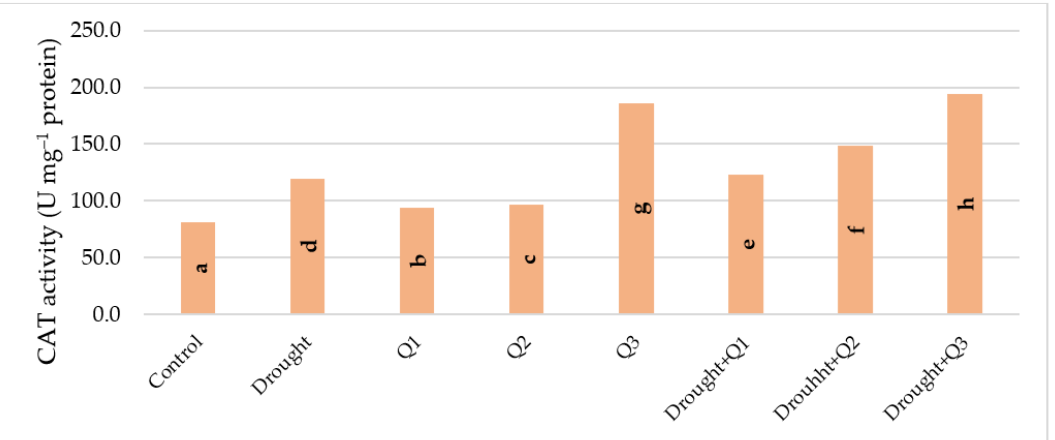
Figure 2. Effect of quercetin derivative concentrations and drought stress on CAT activity. Different letters indicate significant differences between each quercetin–Cu complex concentration, according to ANOVA (followed by Tukey’s HSD test, p =